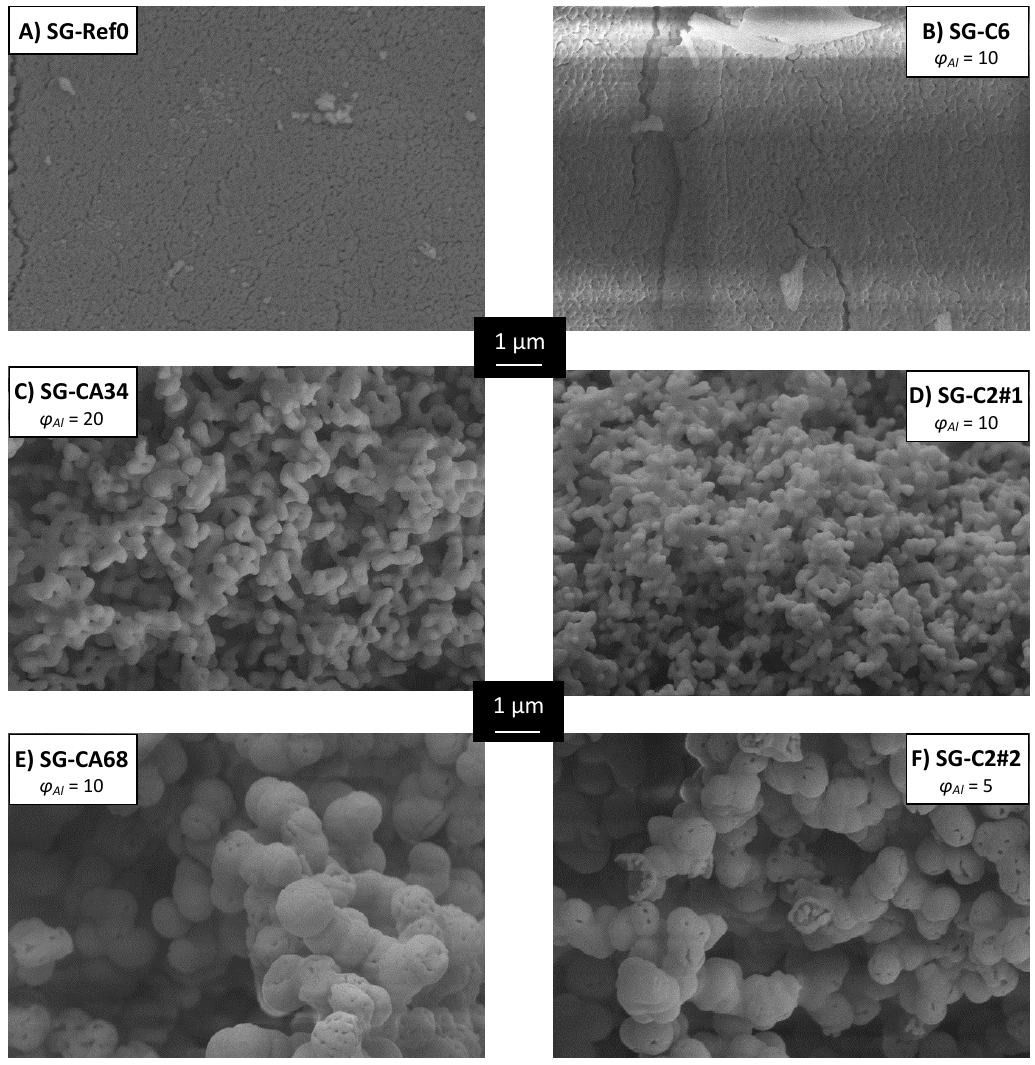
Figure 6. SEM images of sol-gel samples reveal the influence of di ff erent additives ( A ) SG-Ref0: none, ( B ) SG-C6: adipic acid, ( C ) SG-CA34 and ( E ) SG-CA68: citric acid, ( D ) SG-C2#1 and ( F ) SG-C2#2: oxalic acid) and their respective amount on the microstructure. ϕ Al designates the molar ratio of Al 3 + / additive. All samples were calcined at 1200 ◦ C for 6 h to yield α -Al 2 O 3 (cf. Figure 4)